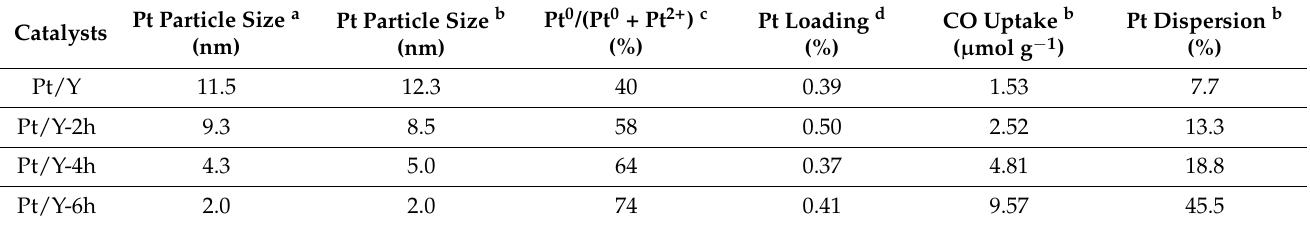
Table 2. Transmission electron microscopy (TEM), X-ray photoelectron spectroscopy (XPS), induc- tively coupled plasma-atomic emission spectrometry (ICP-AES), and CO chemisorption analysis results for the Pt/Y zeolites.